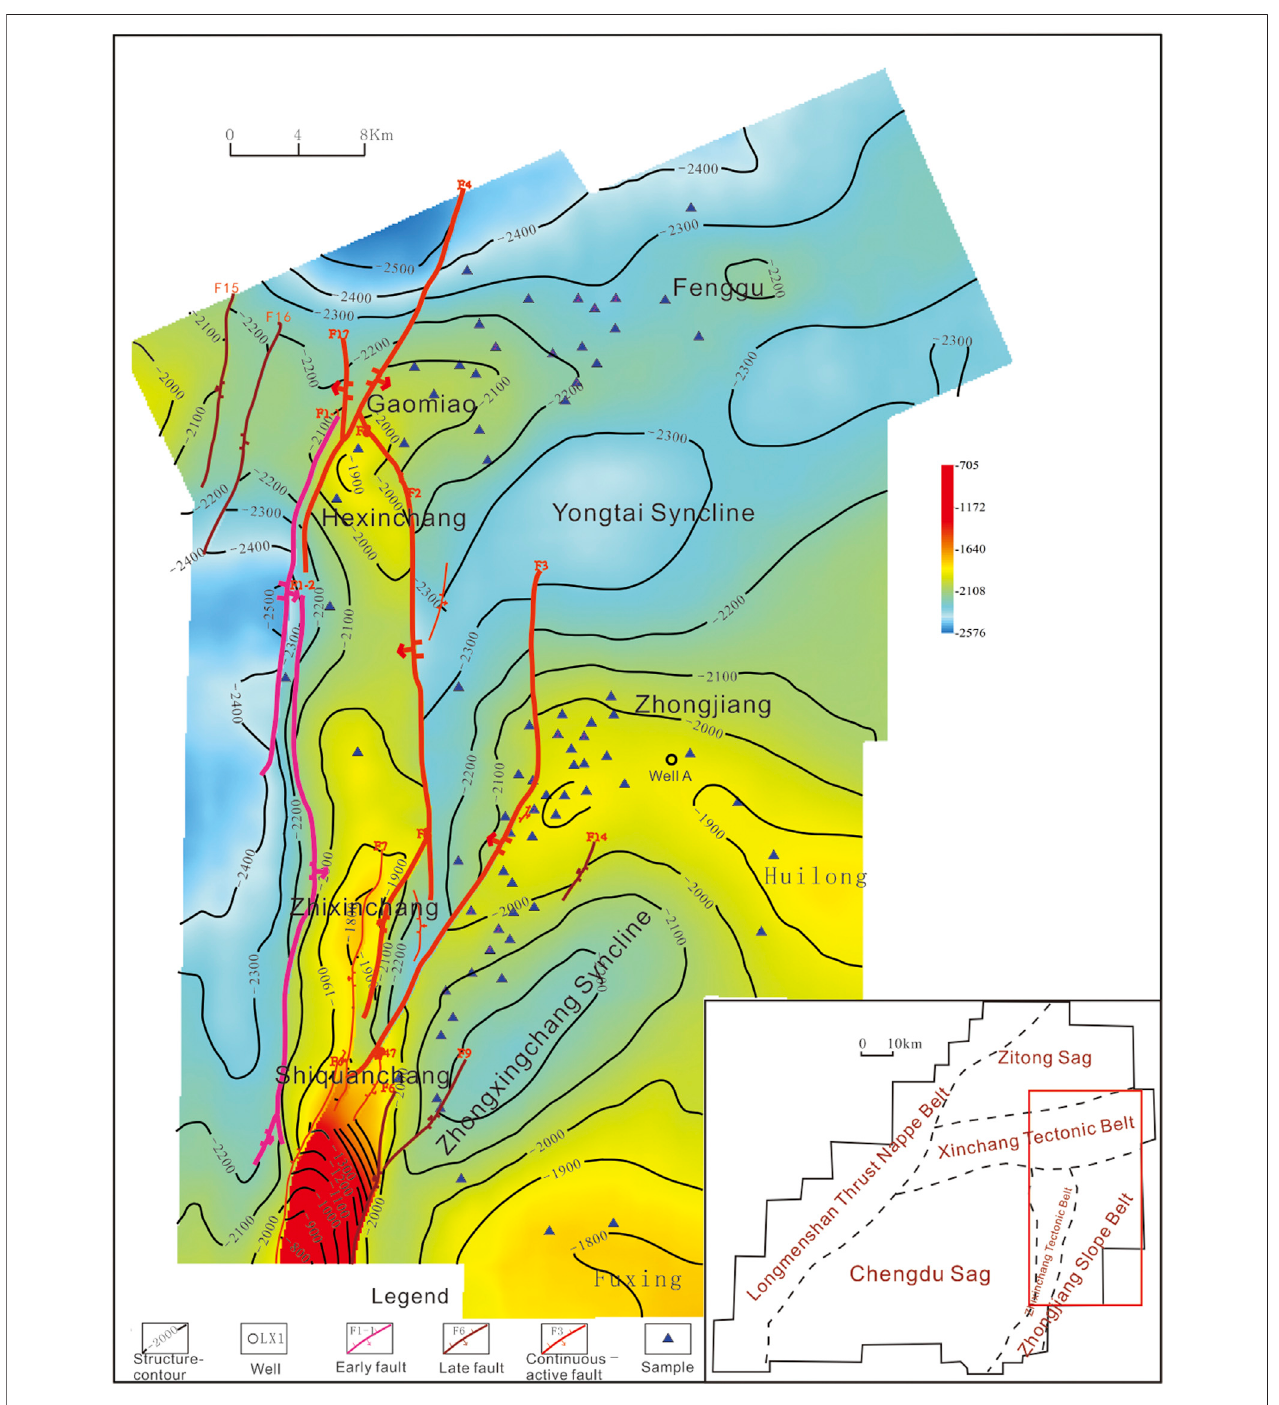
FIGURE 3 | Top structure map of the Shaximiao Formation in the Zhongjiang gas fi eld.